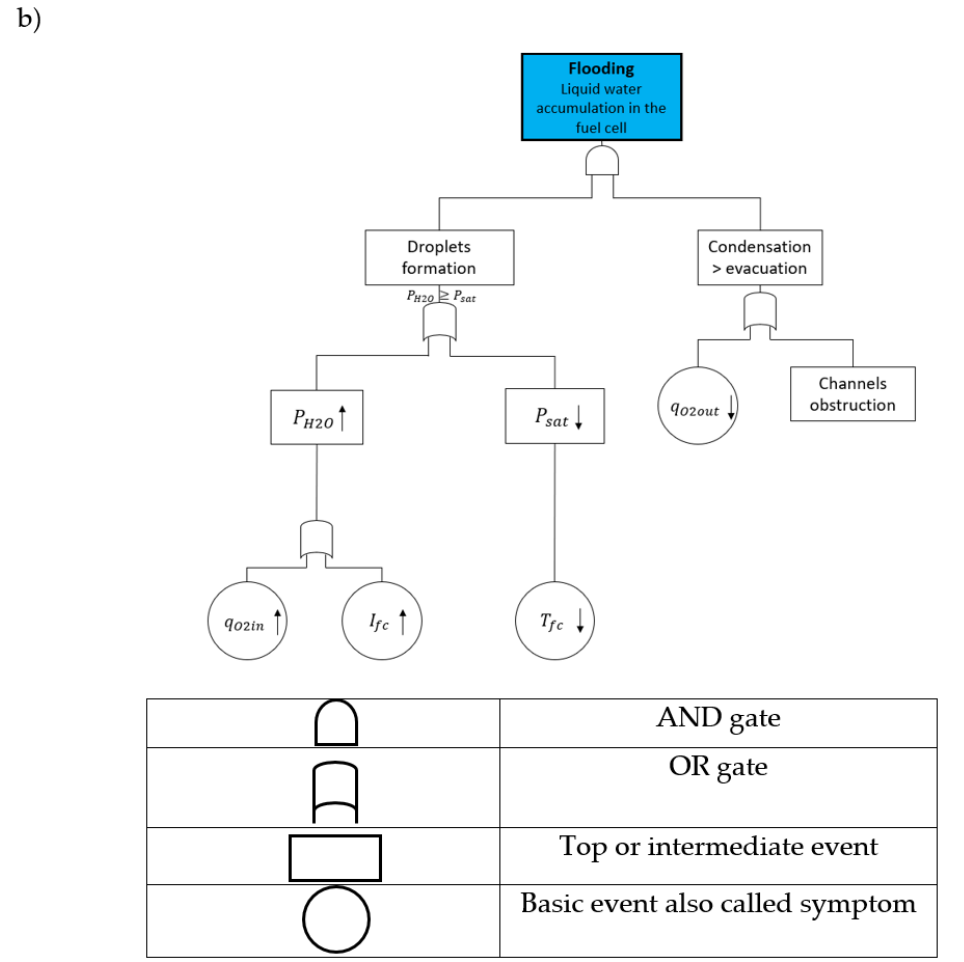
Figure 1. FTA applied on membrane drying out ( a ) and on a flooding ( b ) reproduced with the permission from Yousfi Steiner et al., 2021 [9].